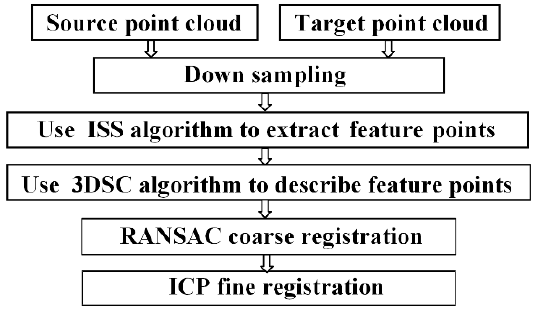
Figure 1. Flow chart diagram of the proposed method.